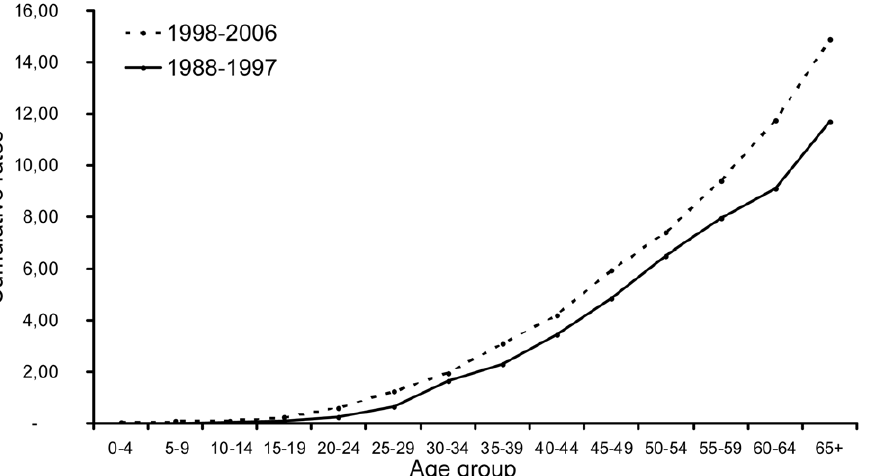
Figure 3. Female comparative liver cancer trends over two periods of 10 (1988–1997) and 9 (1998–2006) years, by age group.